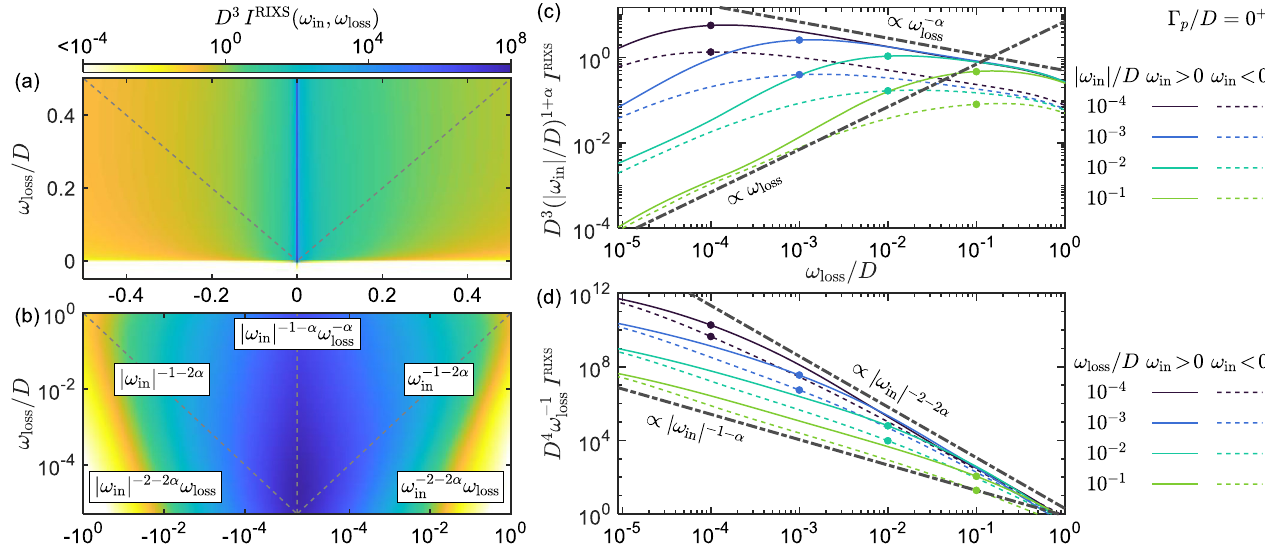
FIG. 9. RIXS spectrum I RIXS ð ω or logarithmic frequency scales. (c) Line cuts of I RIXS as a function of ω ω ω ). (d) Analogous to (c), with the roles of ω loss ¼ j in j in Eq. (99), and in (b) using legends placed at positions indicating the corresponding values of j ω